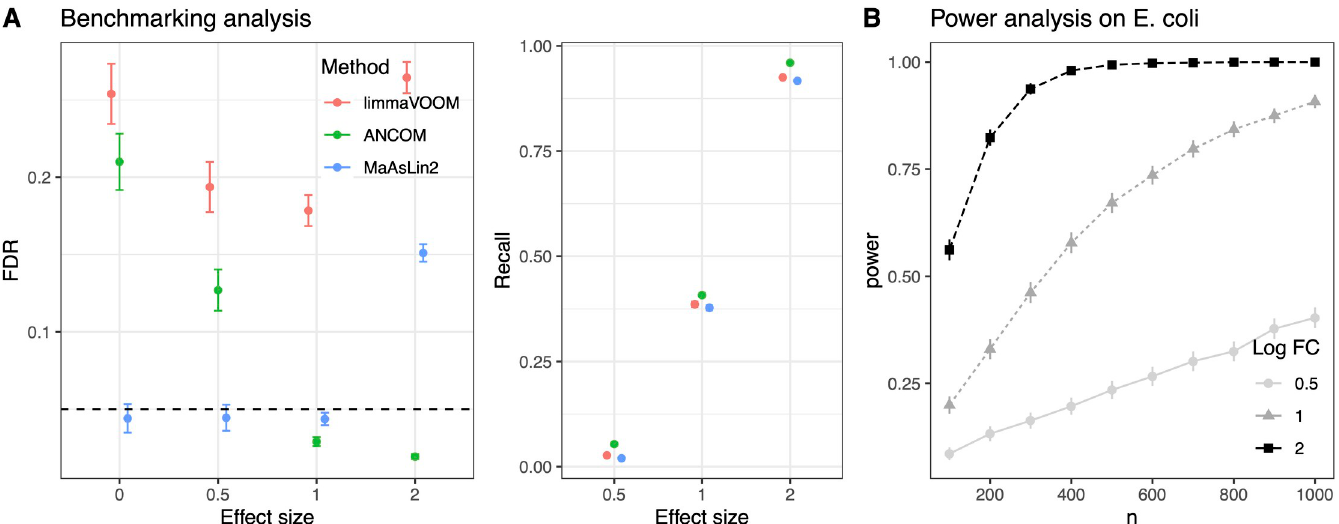
Fig 4. SparseDOSSA enables comparative benchmarking and power analysis of microbial community statistical association tests. For any originating community type of interest, datasets simulated based on a SparseDOSSA model fit can be spiked with known "phenotypes" and feature effect sizes to estimate methods performance (power, FPR, etc.) during ( A ) benchmarking as well as ( B ) power analysis, across controlled combinations of potential effect sizes and sample sizes. Points indicate average performance across simulation repetitions and error bars indicate standard error ( Methods ).